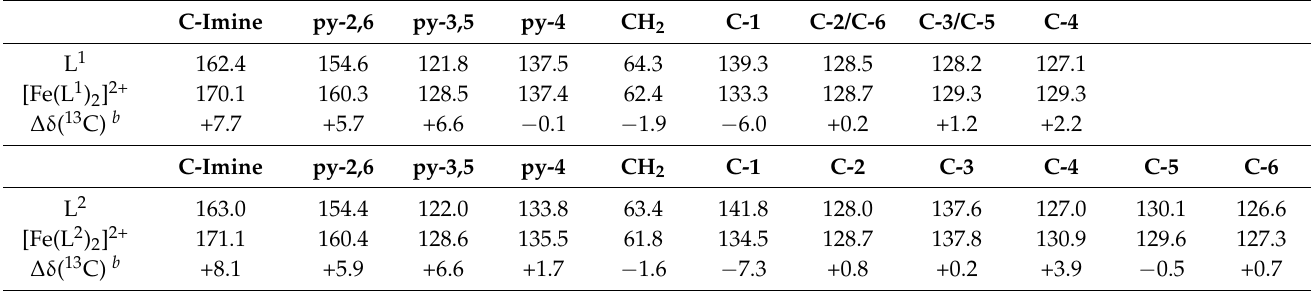
Table 2. Experimental 13 C NMR shifts (in ppm vs. TMS) in free ligands L 1 , L 2 and